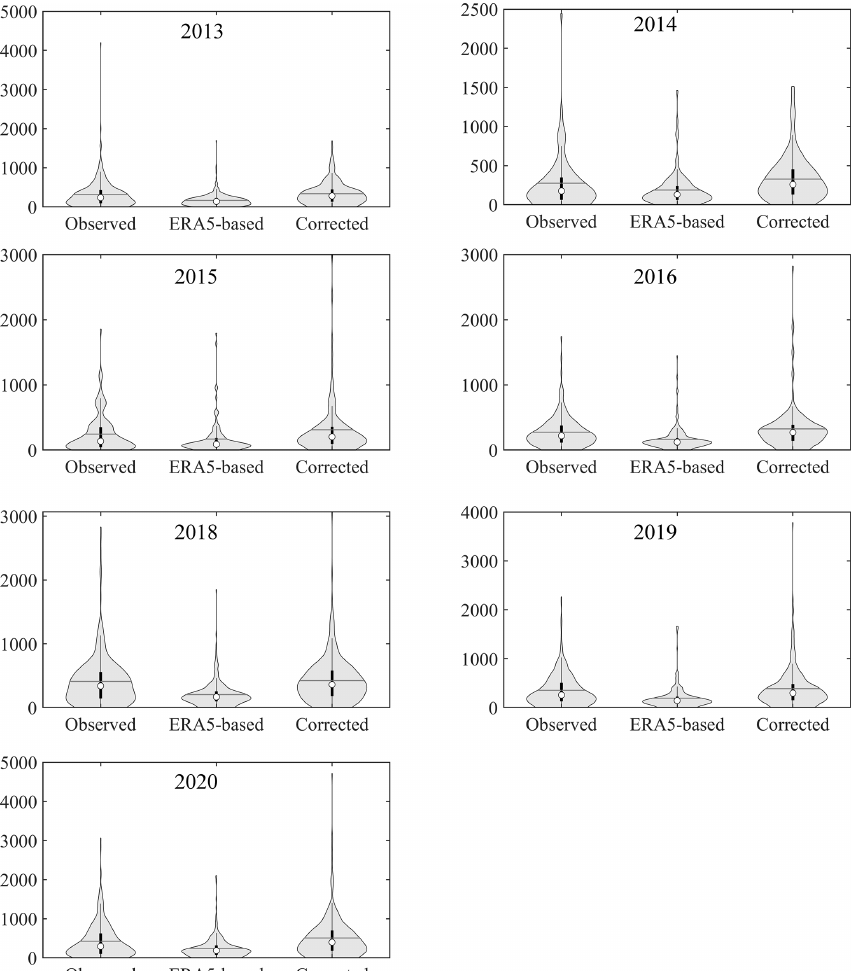
Figure 10. Violin plots of observed, ERA5-based, and corrected annual rainfall erosivity in validation grids for 2013–2020 (excluding 2017). The Y axis shows the annual rainfall erosivity in MJmmha − 1 h − 1 . The boxplot diagram of the median of the violin plots shows the maximum value, 75% quantile value, 50% quantile value, 25% quantile value, and minimum value. The horizontal lines represent average